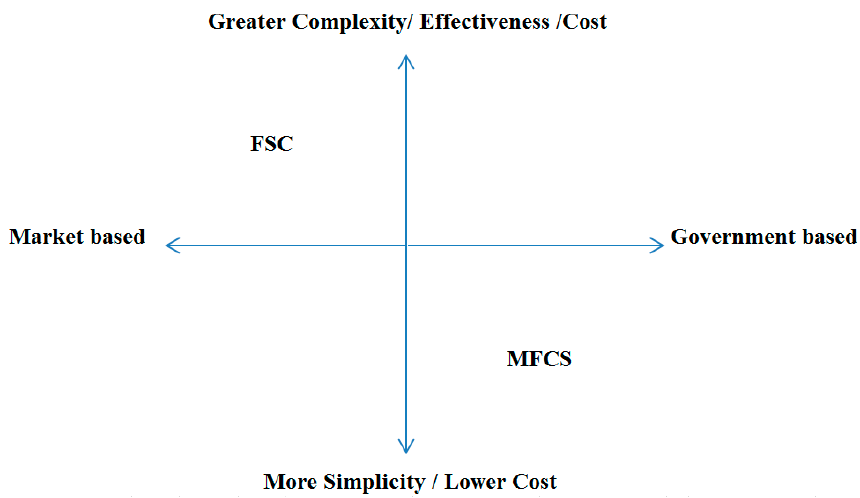
Figure 1. Conceptual Model of Forestry Certification Characteristics (FSC = Forest Stewardship Council Certification System, MFCS = Mexican Forest Certification System).